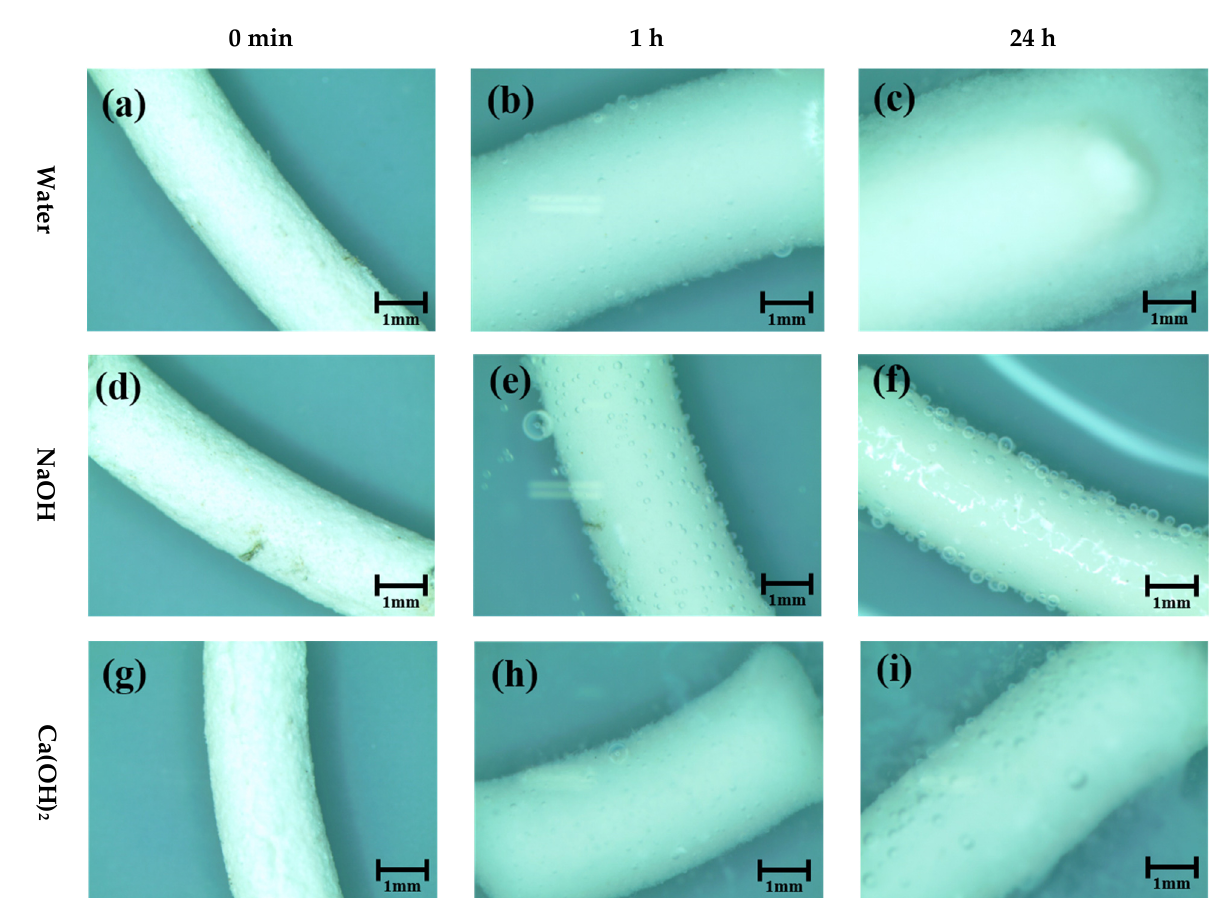
Figure 4. Pellet expansion behavior in water ( a – c ), 1 M NaOH ( d – f ), and saturated Ca(OH)2 solution ( g – i ).